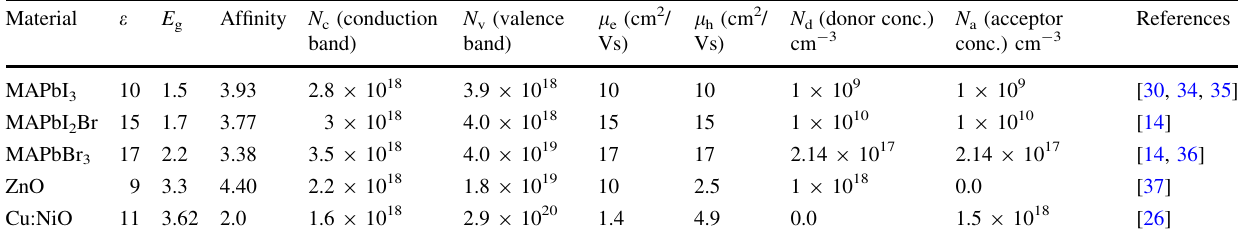
Table 1 Basic material parameters used for the simulation, which were carefully chosen from experimental reports [14, 23, 31]